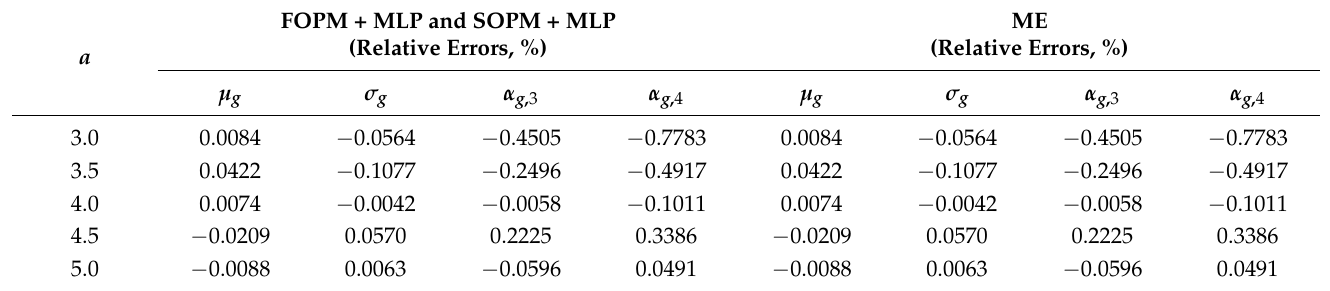
Table 2. Relative errors of the first four statistical moments calculated by FOPM + MLP, SOPM + MLP and